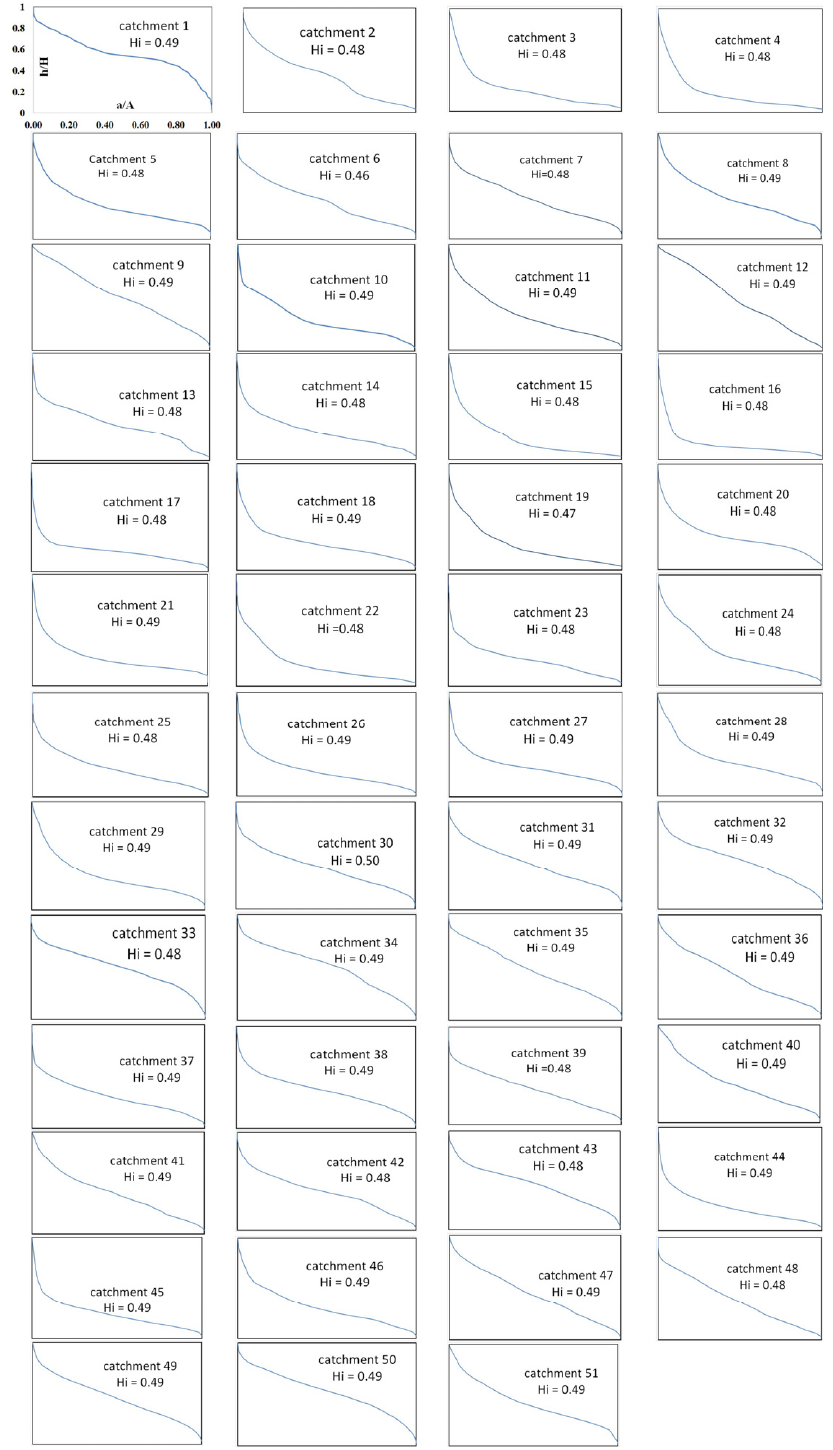
Figure 7. Hypsometric curves of the catchments. (A) Total surface of the catchment. (a) Surface area within the catchment above a given line of elevation (h). (H) Highest elevation of the catchment.